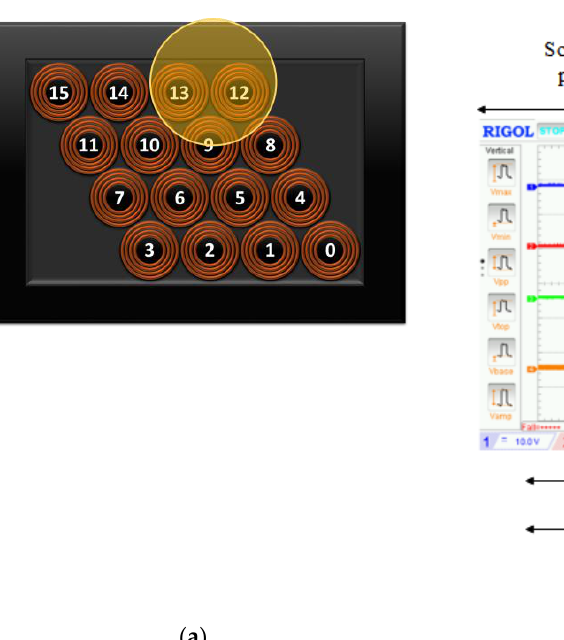
Figure 21. Receiving coil voltages measured by the WSN for different receiving coil positions: ( a ) On the top of C0, ( b ) On the top of C15.